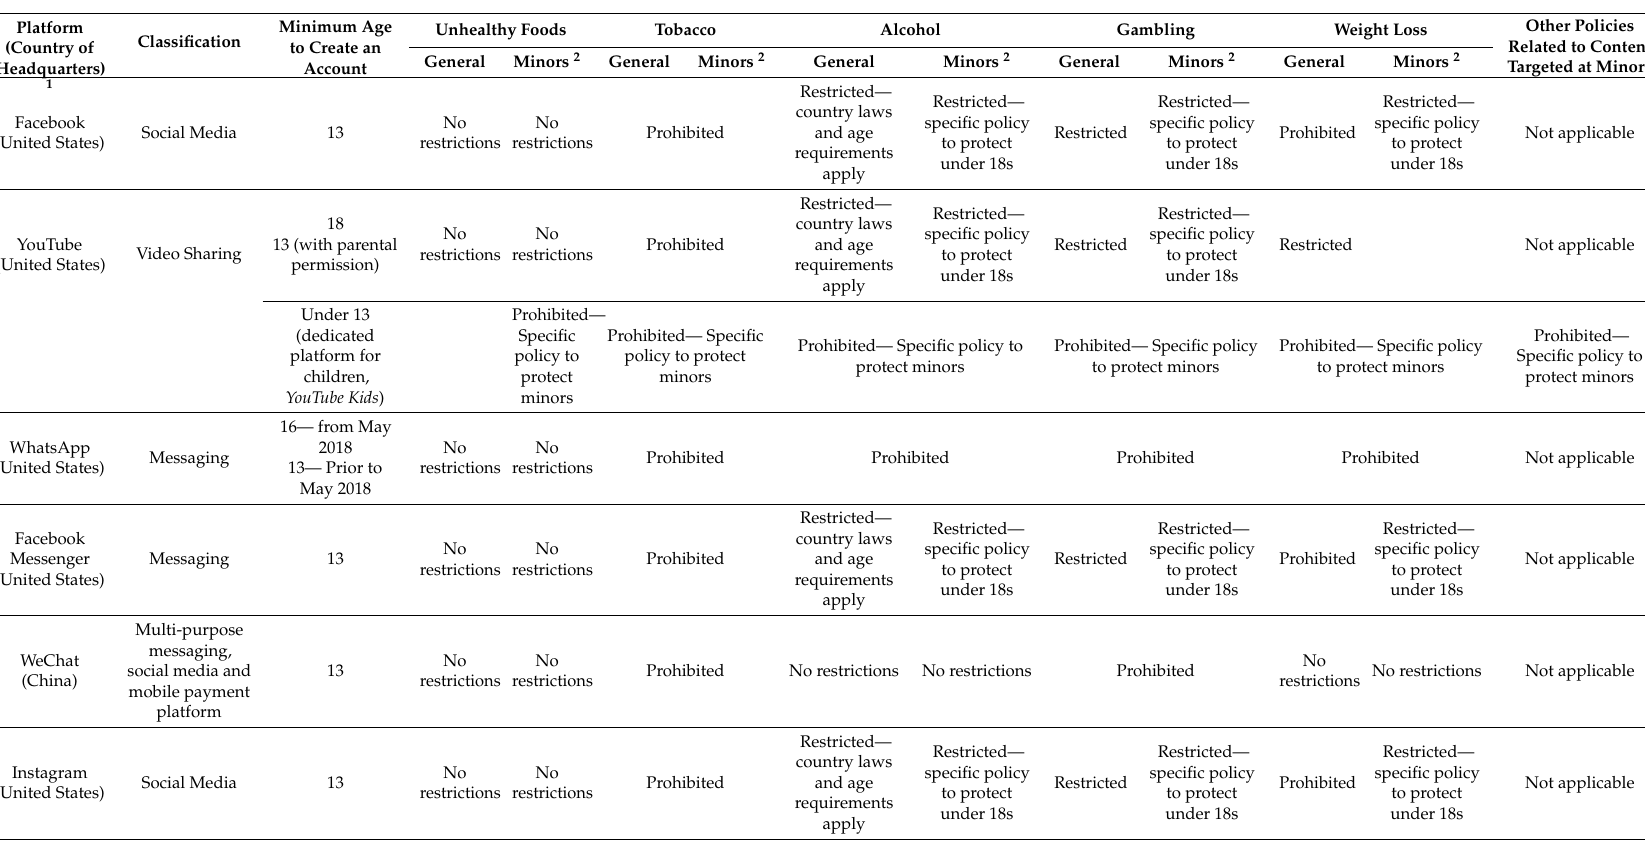
Table 1. Advertising policies of sixteen major social media platforms in relation to unhealthy foods, tobacco, alcohol, gambling and weight-loss, as of December 2019. Platform (Country